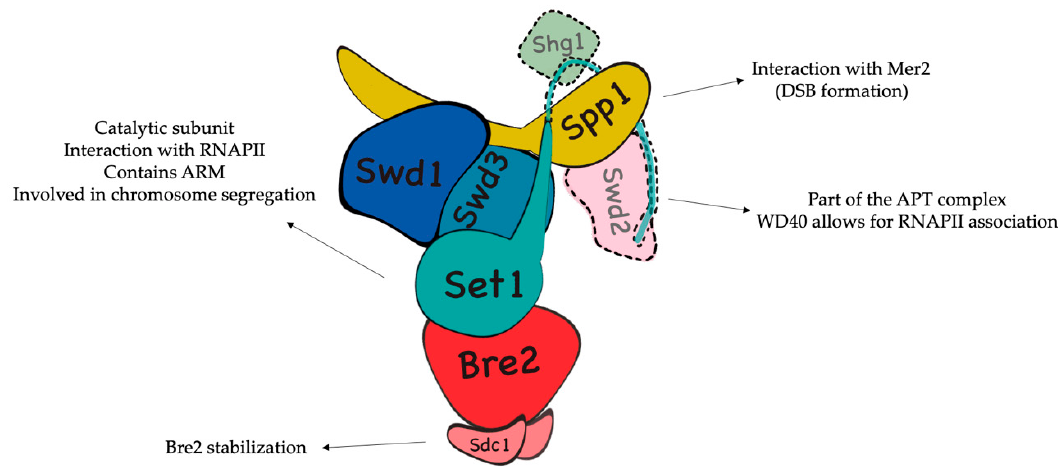
Figure 3. The Complex of Proteins Associated with Set1 (COMPASS). The subunit arrangement model shown here is inspired from the cryo-electron microscopy (EM) structure published by Qu et al. in 2018 [74], which featured a truncated version of Set1, without the N-terminal. This region, as well as Shg1 and Swd2 subunits, have been added to the model (dotted lines). In red (Bre2, Sdc1, and Swd) are the subunits necessary for H3K4me2 / 3; in blue (Set1, Swd1, and Swd3) are the subunits necessary for H3K4me1 / 2 / 3; and in yellow is Spp1, which is necessary for H3K4me3. Little is known about Shg1. The structure is accompanied by several processes in which COMPASS subunits participate.